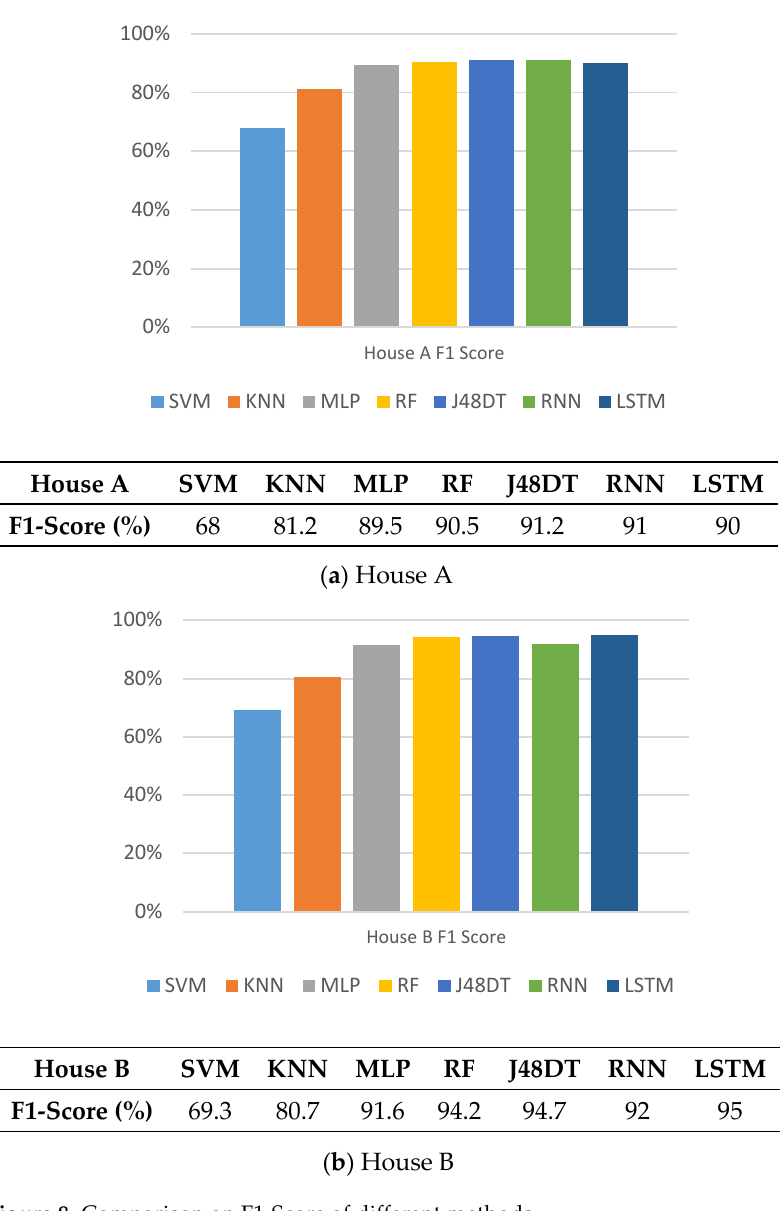
Figure 8. Comparison on F1-Score of different methods.